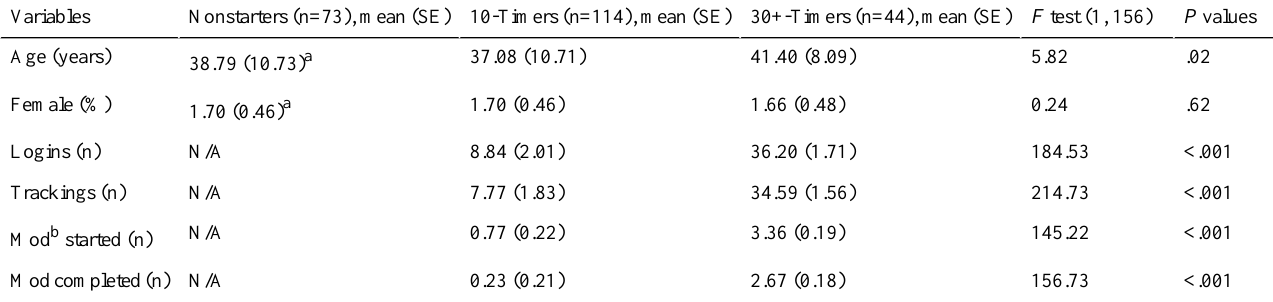
Table 2. Cluster analysis groupings of 158 myCompass randomized controlled trial participants’usage behaviors and multivariate analysis of variance testing of the significant difference between clusters.